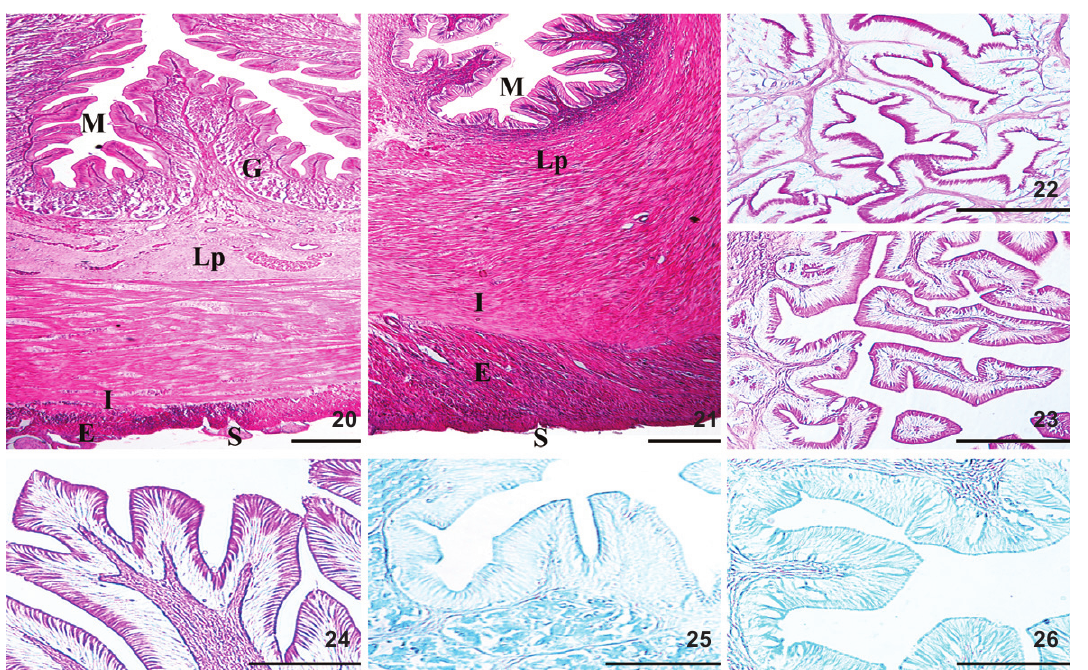
Figures 20-26. Histological organization of the stomach: (20) Cardiac region showing: mucosa (M), gastric glands (G), lamina propria (Lp), internal muscular layer (I), external muscle layer (E), serosa (S), HE, (bar = 500 µm). (21) Pyloric region highlighting the mucosa (M), lamina propria (Lp), internal muscle layer (I), external muscle layer (E), serosa (S), HE, (bar = 500 µm). (22) Cardiac region showing a positive reaction in the apex of the PAS prismatic cell, (bar = 200 µm). (23) Fundic region showing a positive reaction in the apex of the PAS prismatic cell, (bar = 200 µm). (24) Pyloric region showing a positive reaction in the apex of the PAS prismatic cell, (bar = 100 µm). (25) Cardiac region showing Ab pH 2.5 – Positive reaction in the prismatic cell apex, (bar = 200 µm). (26) Pyloric region showing Ab pH 2.5 – Positive reaction in the prismatic cell apex, (bar = 100